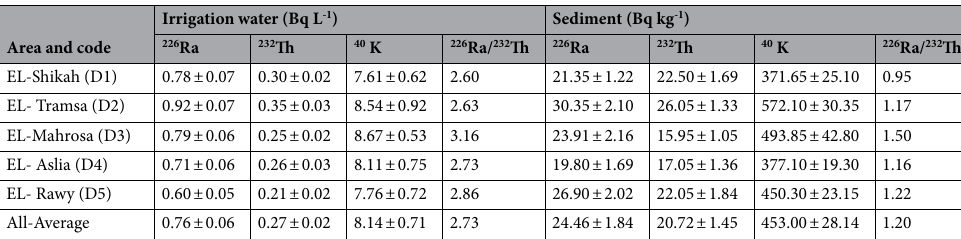
Table 1. Average activity concentration of 226 Ra, 232 Th, and 40 K and 226 Ra/ 232 Th ratio in irrigation water and sediment from Qena governorate,